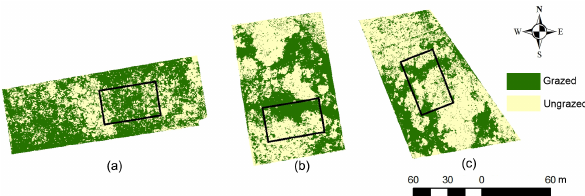
Figure 1. Images with digitally classified grazed and ungrazed ar- eas in grassland paddocks of different stocking rate: (a) moderate, (b) lenient and (c) very lenient. Black boxes indicate the location of 30 × 50m study plots. Photos were taken in April